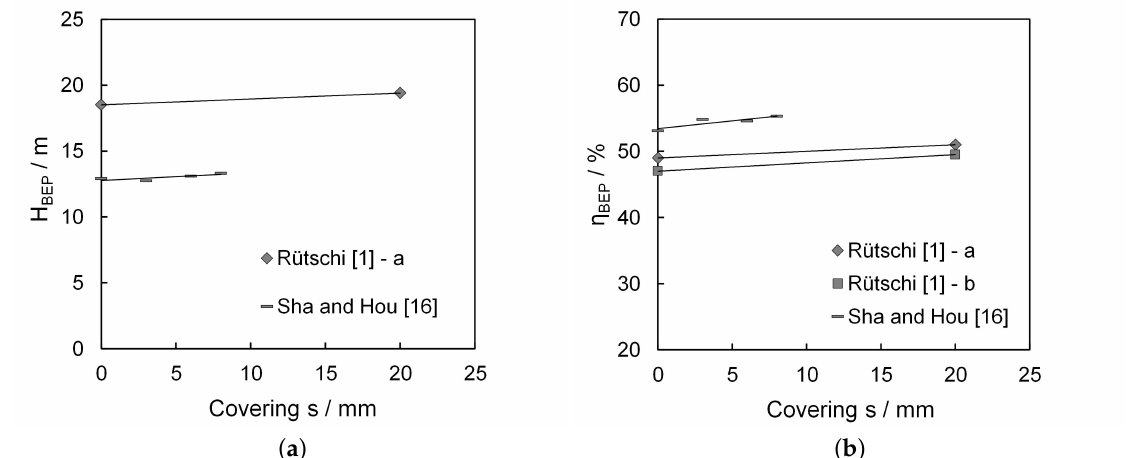
Figure 17. ( a ) Head over covering; and ( b ) efficiency over covering.